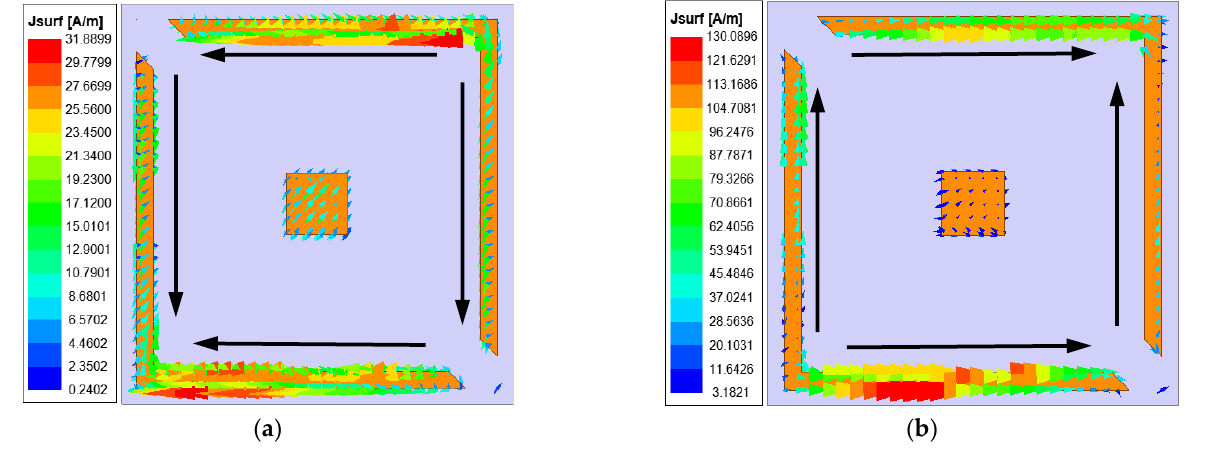
Figure 7. Surface current distributions at their resonance frequencies of ( a ) 10 GHz; ( b ) 23 GHz.